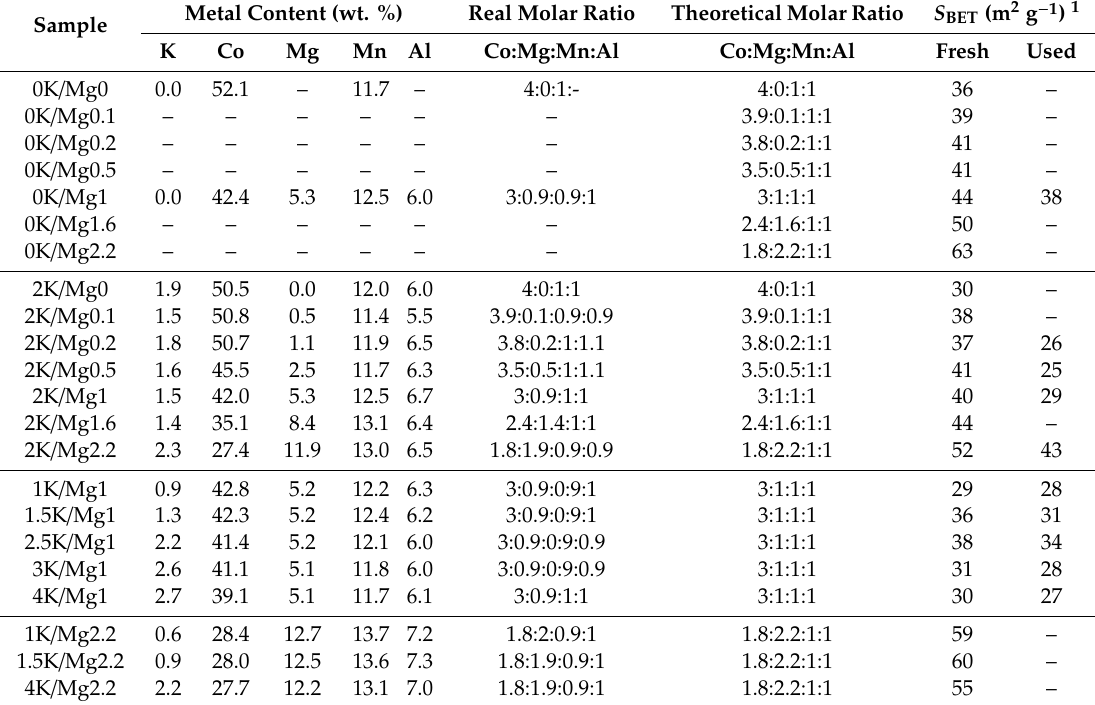
Table 1. Chemical composition and specific surface area of K / Co-Mg-Mn-Al mixed oxide catalysts. Metal Content (wt. %) Real Molar Ratio Sample